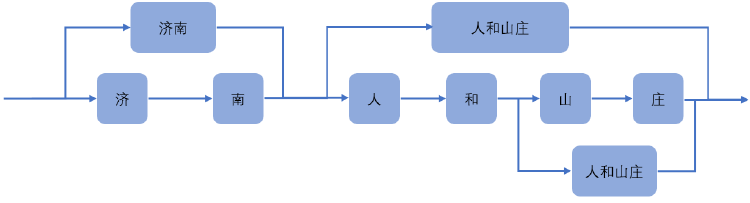
Figure 7. Structure diagram of Lattice.